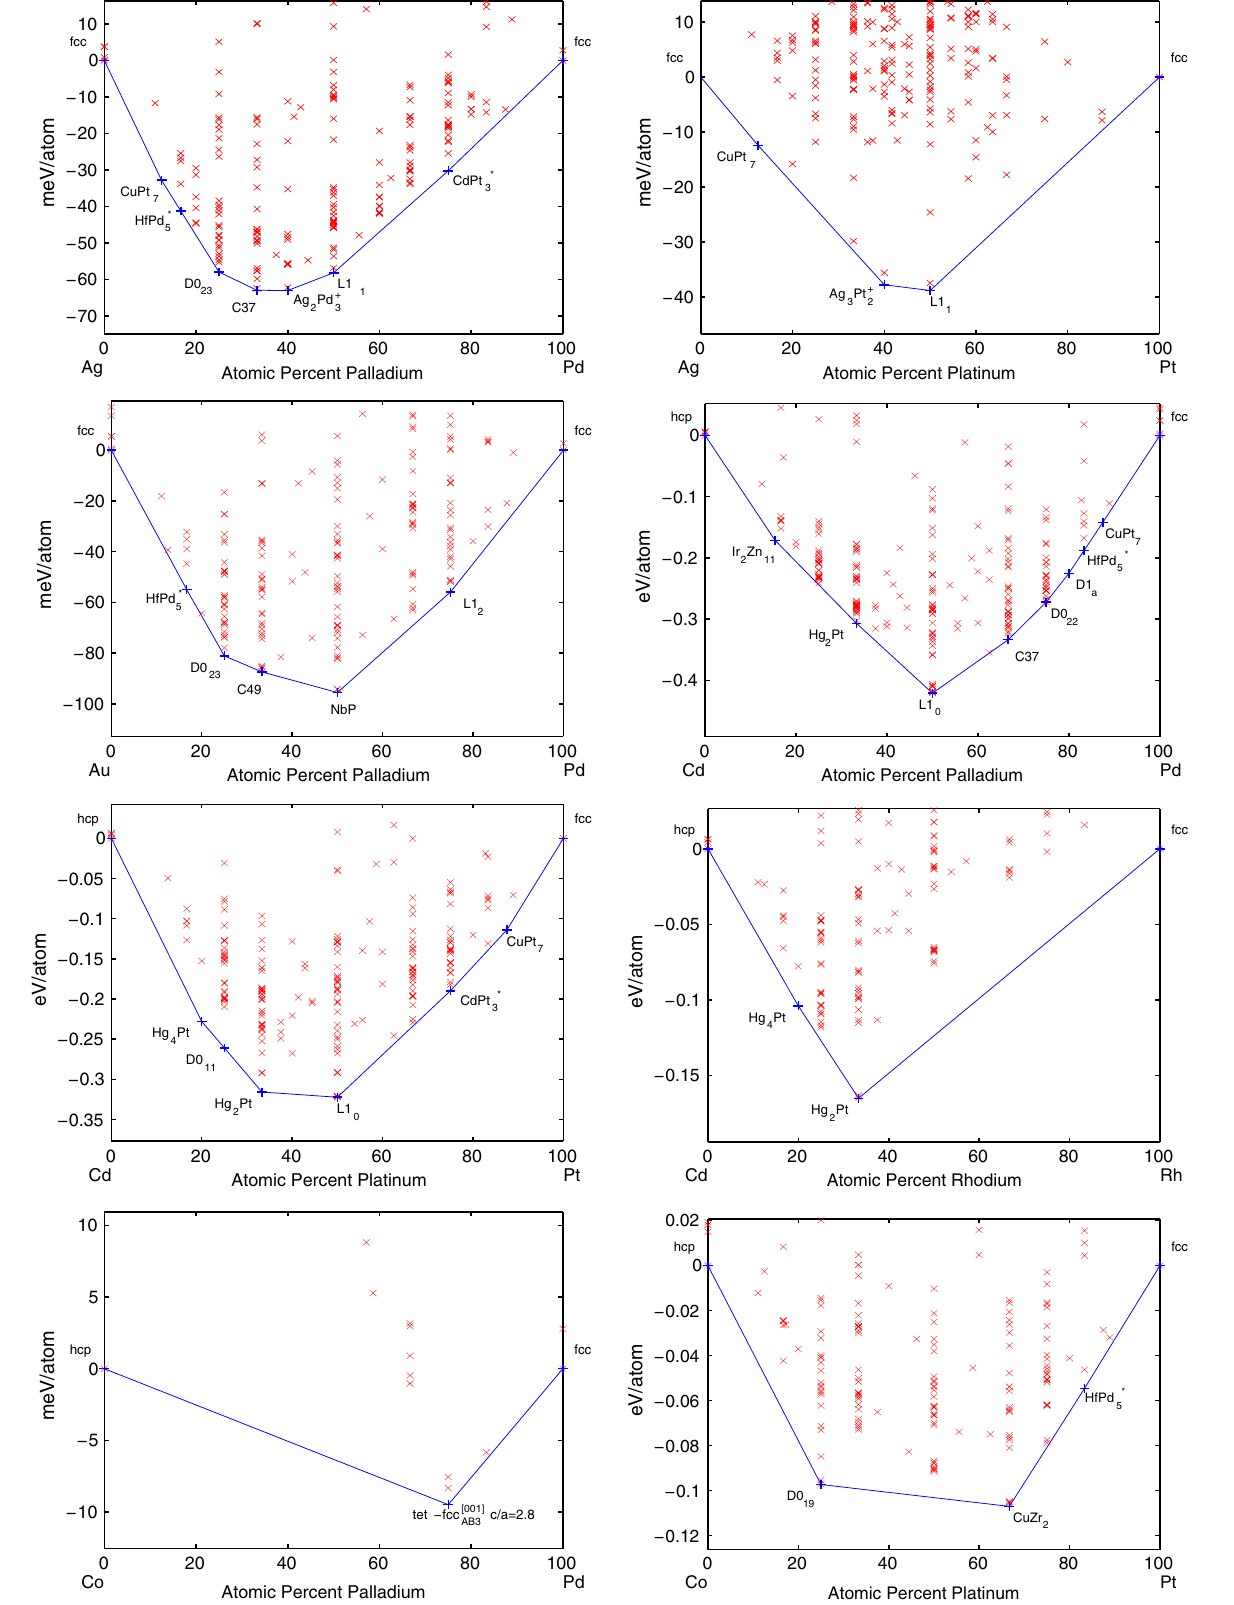
FIG. 5. Convex hulls for the systems Ag-Pd, Ag-Pt, Au-Pd, Cd-Pd, Cd-Pt, Cd-Rh, Co-Pd, and